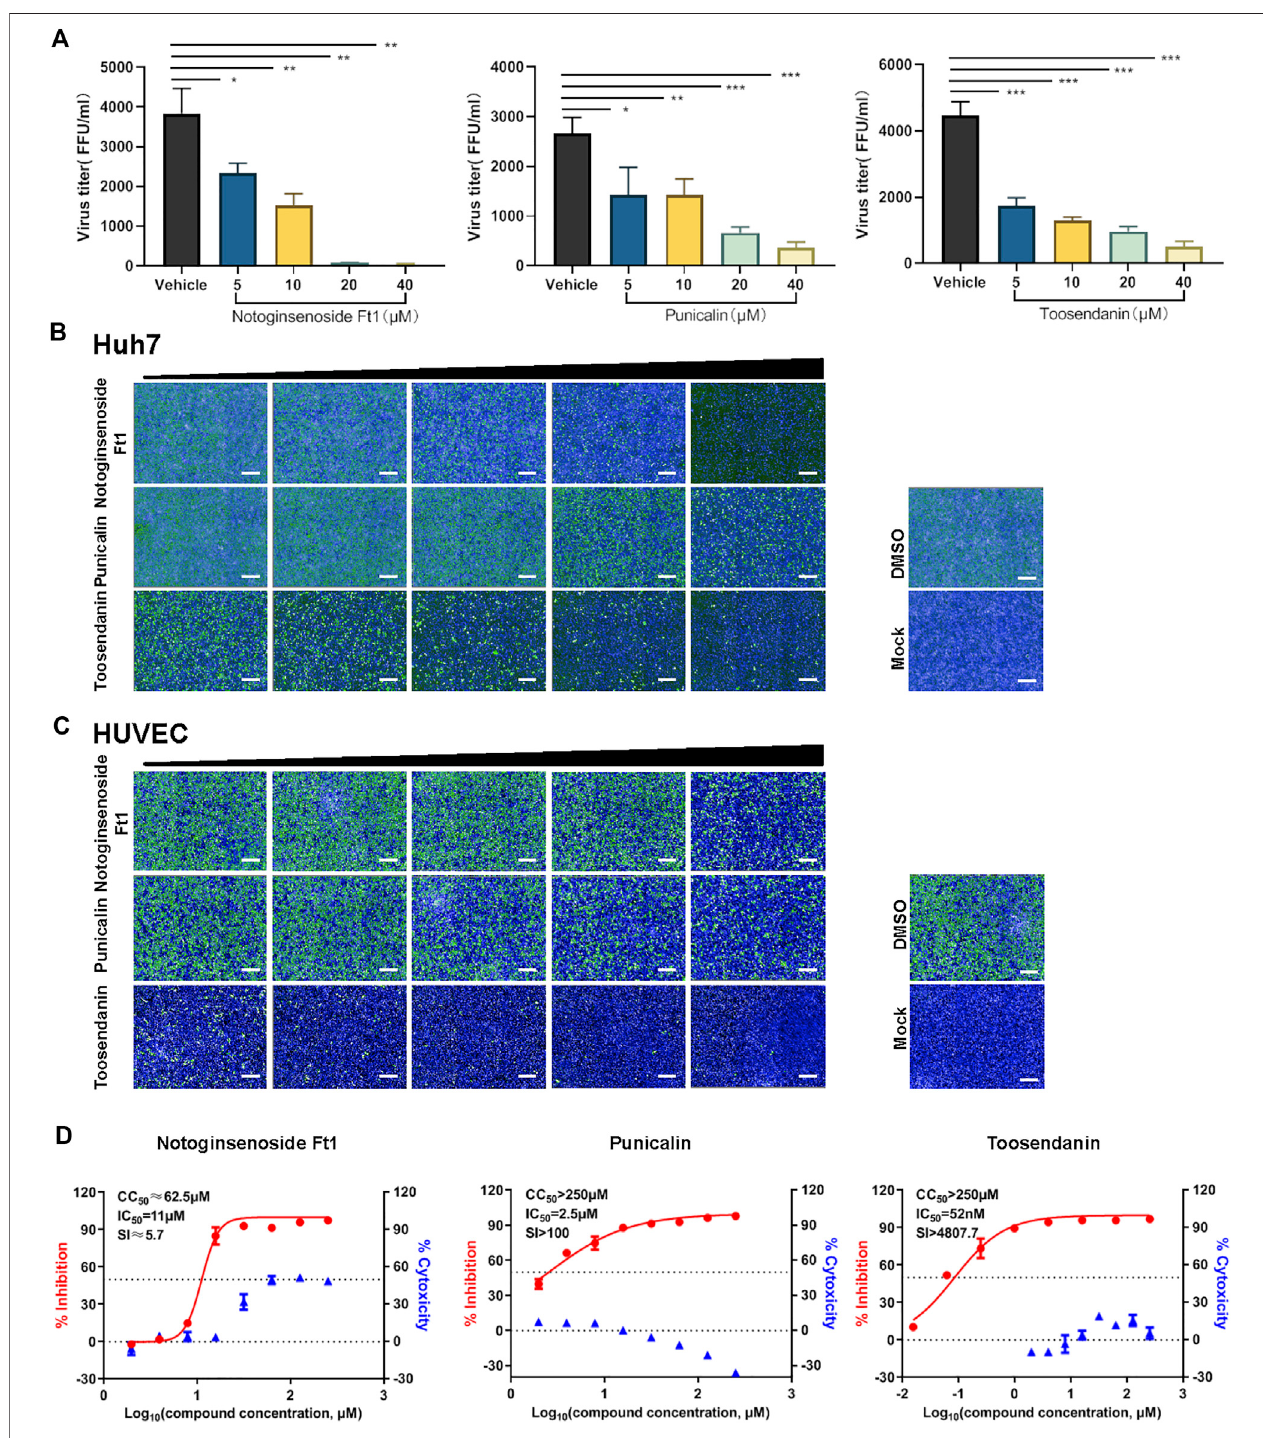
FIGURE 2 | Validation of the anti-viral activity of the hit compounds in different cell lines. (A) Vero cells pre-treated with different concentrations of drugs were infected withSFTSVat anMOIof0.125.Cellculturesupernatantswereharvestedforviral titration assayat 24 hpi. (B,C) The anti-SFTSV activity ofthreecompounds on Huh7 (B) and HUVEC (C) cells. Cells were pre-treated with different concentrations of drugs and infected with SFTSV at an MOI of 1. Cells were fi xed for immuno fl uorescence assay at 36 hpi. Bars represent 500 μ m. (D) The dose-dependent inhibitory activity of three compounds against SFTSV infection on HUVEC cells. The left and right Y -axis represent inhibition and cytotoxicity rate of the drugs, respectively. Data shown are means ± SD ( n (cid:1) 3). Comparison of mean values (A) between two groups were analyzed by Student ’ s t test. * p < 0.05; ** p < 0.01; *** p < 0.001.